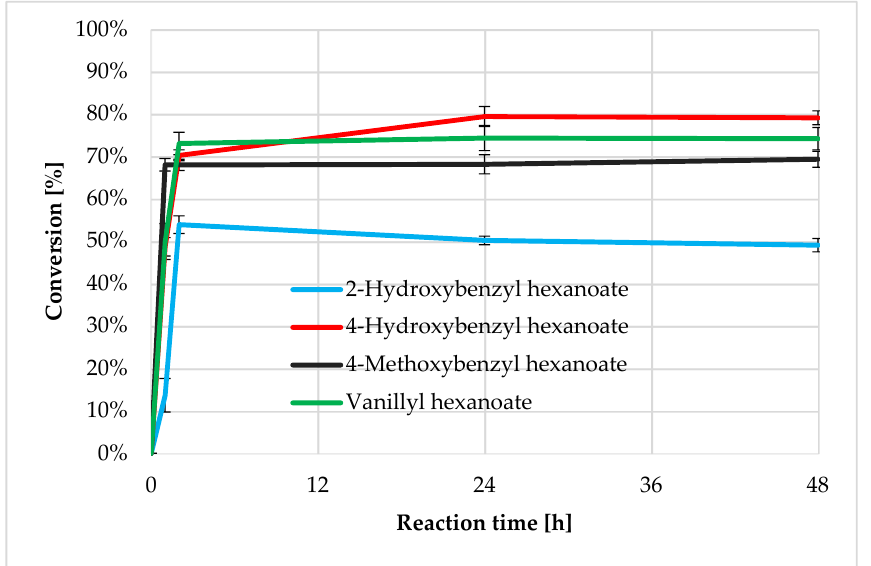
Figure 2. Percentage conversion (% ± SD) of aromatic alcohols and hexanoic acid to their esters with CALB after 1, 2, 24, and 48 h of reaction